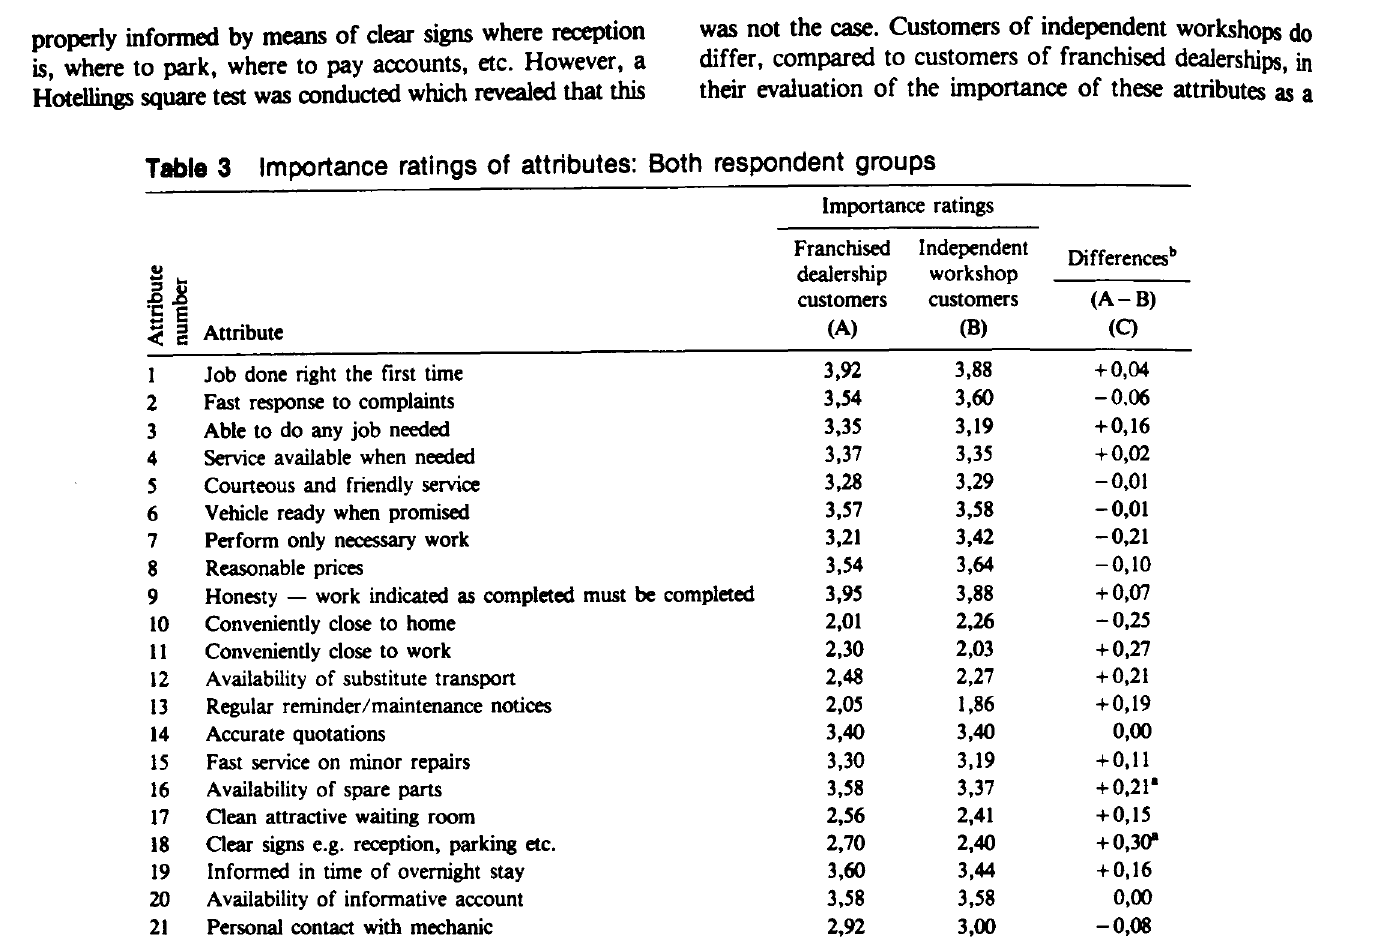
Perfonnance ratings of attributes: Both respondent groups